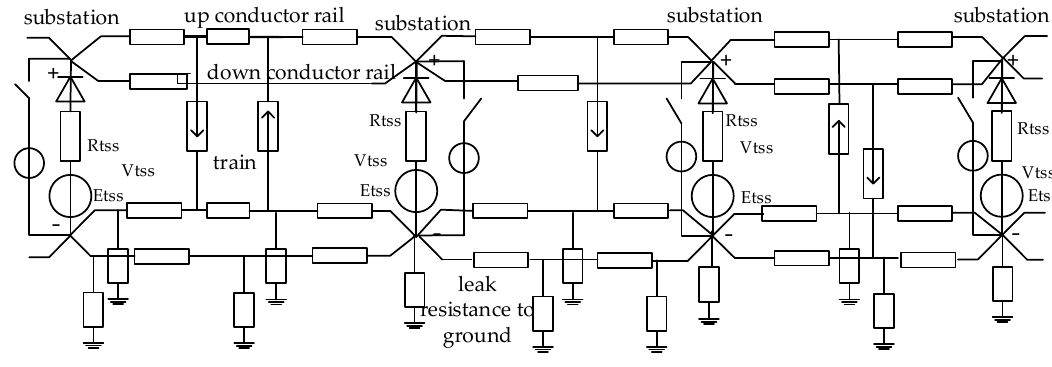
Figure 8. Equivalent circuit of the DC power supply system.